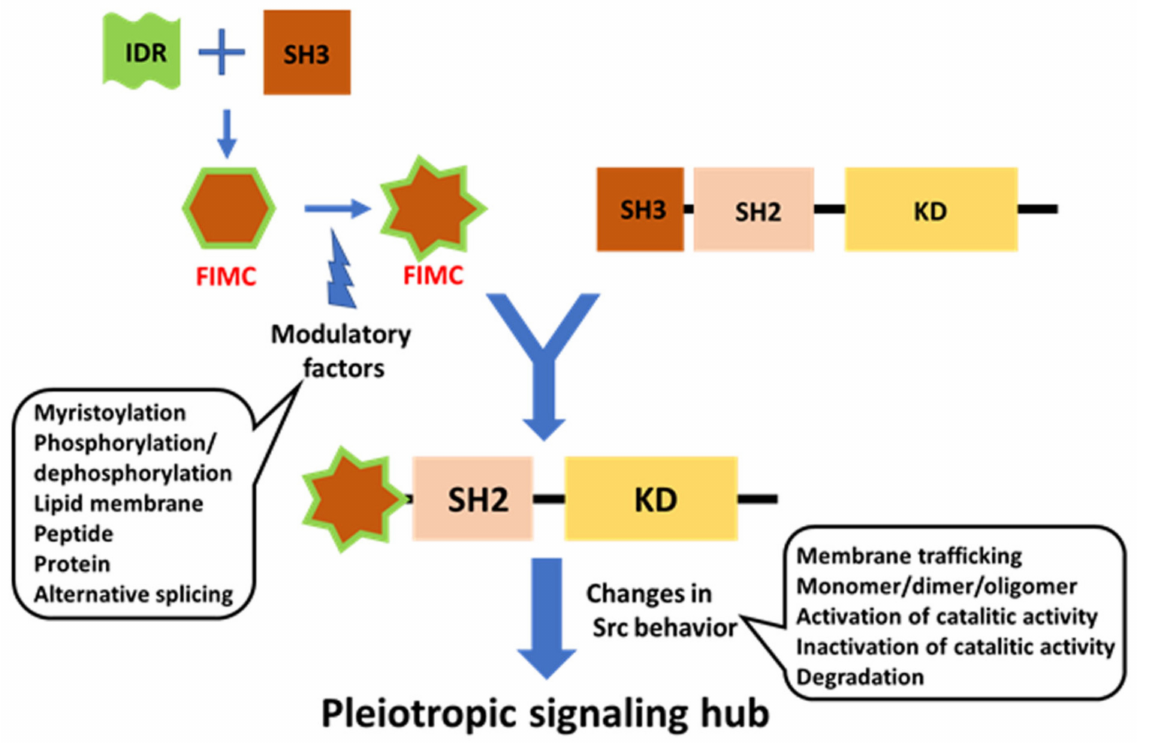
Figure 6. Schematic diagram of potential FIMC-directed Src regulation. The FIMC directs full-length Src behavior spatiotemporally. The FIMC comprised of IDR scaffolded by SH3 is modulated by post-translational modifications, such as myristoylation and phosphorylation; interactions with lipid membranes and proteins/peptides; and alternative splicing. The FIMC alters the behavior of the full-length Src molecule, including membrane trafficking, dimerization/oligomerization, switching of phosphotransferase activity, and degradation. Thus, Src functions as a pleiotropic signaling hub under spatiotemporal